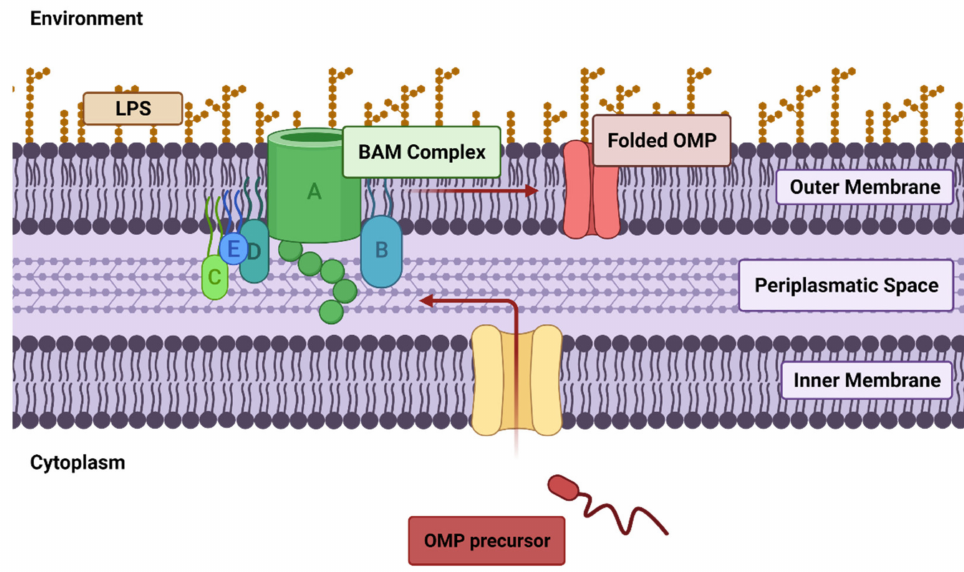
Figure 16. Biogenesis of bacterial OMP. Newly synthesized OMP precursors (red) move from the cytoplasm across the inner membrane and the periplasmic space. The β -barrel assembly machinery (BAM) complex (green), located in the OM, integrates the OMP precursors, creating the folded OMP (orange). Created with BioRender.com (Accessed on 29 April